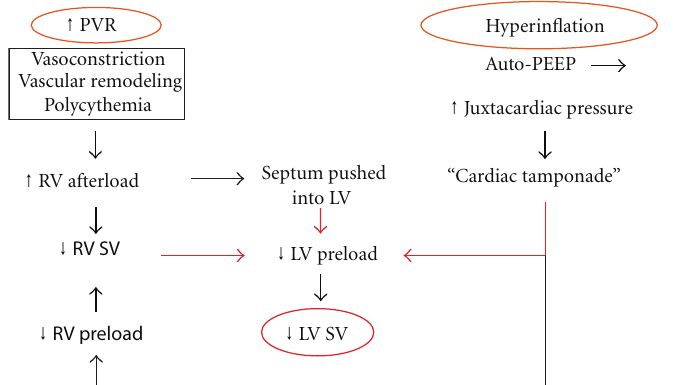
Figure 3: Pathophysiology of reduced SV in COPD. SV: stroke volume, PVR: pulmonary vascular resistance, RV: right ventricular, LV: left ventricular, PEEP: positive end-expiratory